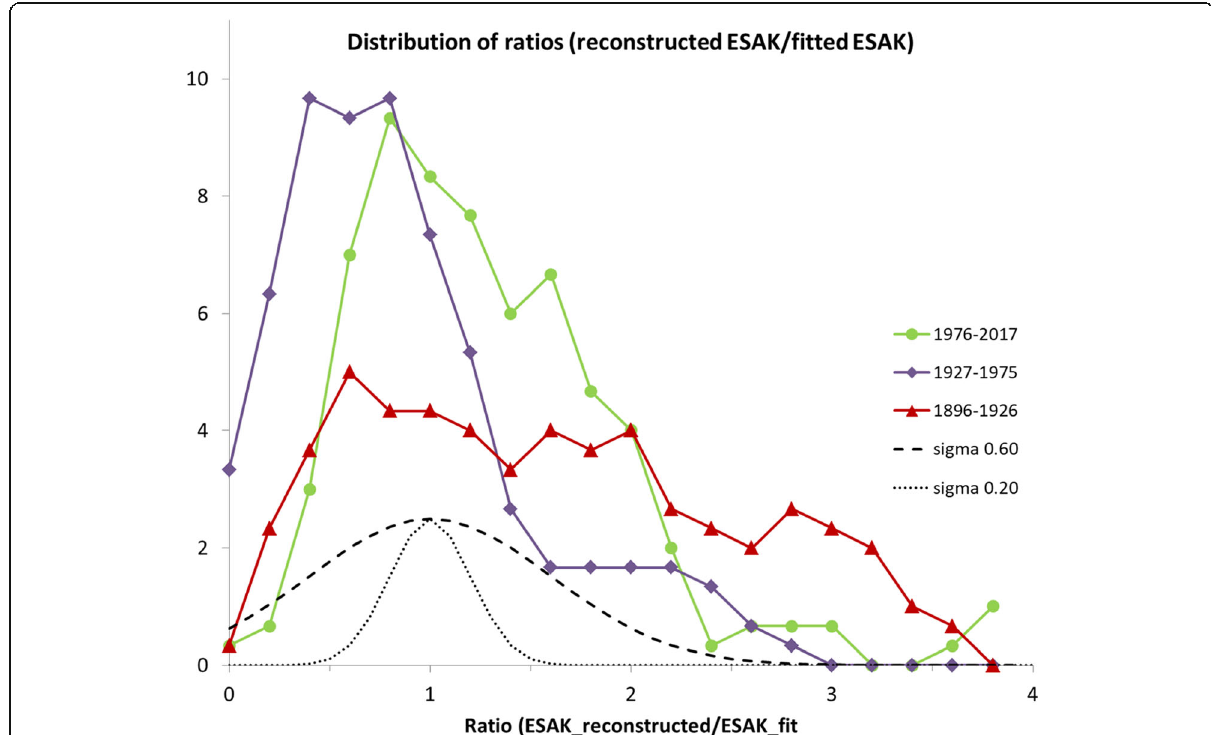
Fig. 5 Distributions of the ratio ESAK(reconstructeded)/ESAK(fit) for three intervals of time. Points summed within intervals (x-axis) of 0.2 and curves smoothed. Dashed curve gives shape of hypothetical distribution of doses according to an estimated maximum standard deviation of 60% in our 1900 – 1910 dose reconstructions. Dotted curve represents the spread of 20% in doses assumed for 1927 – 1957